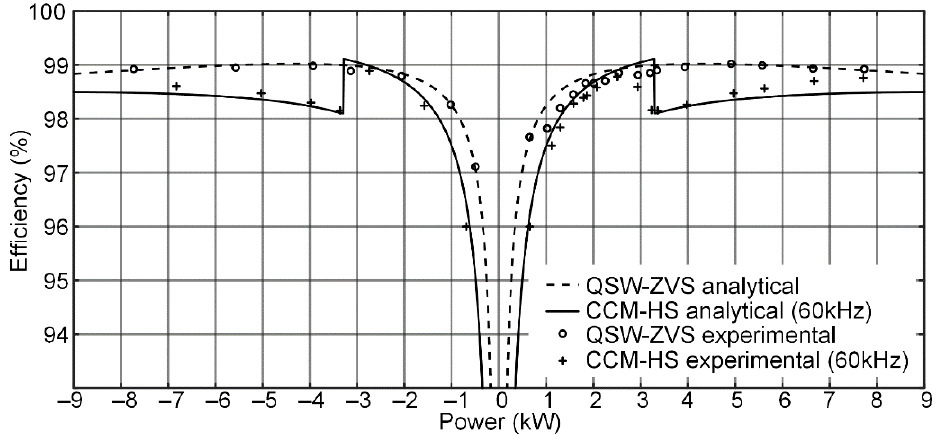
Figure 3. Analytical and experimental efficiency comparison. Positive power is considered when the power flows from V 1 to V 2 . And, conversely, negative power represents power flowing from V 2 to V 1 .